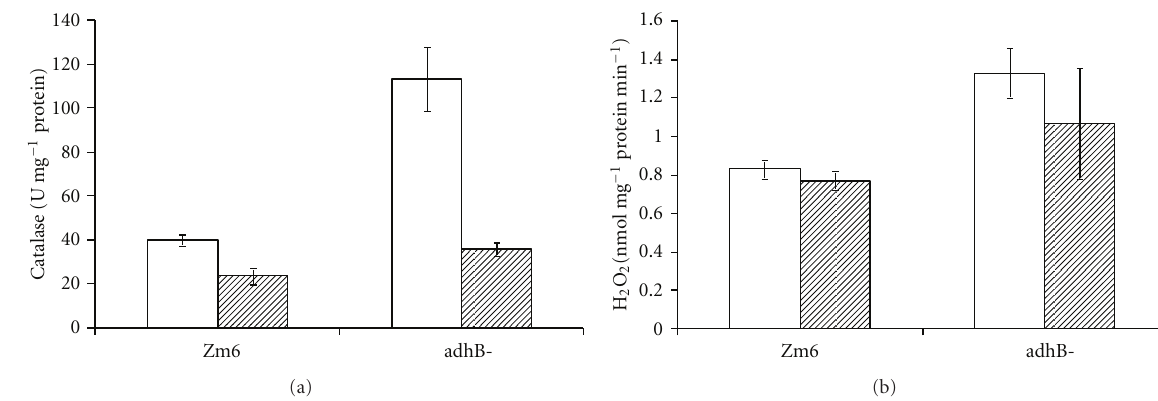
Figure 4: Catalase activity in cell-free extracts (a) and hydrogen peroxide production in stationary phase cell suspensions, supplied with 2.5mM glucose (b); empty bars—aerobically grown cells, filled bars—anaerobically grown cells. Cell suspensions were obtained